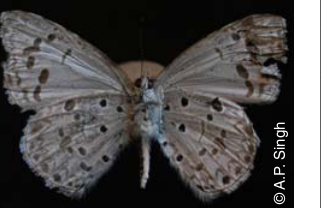
Image 23. Margined Hedge Blue, Celatoxia marginata -male (under)